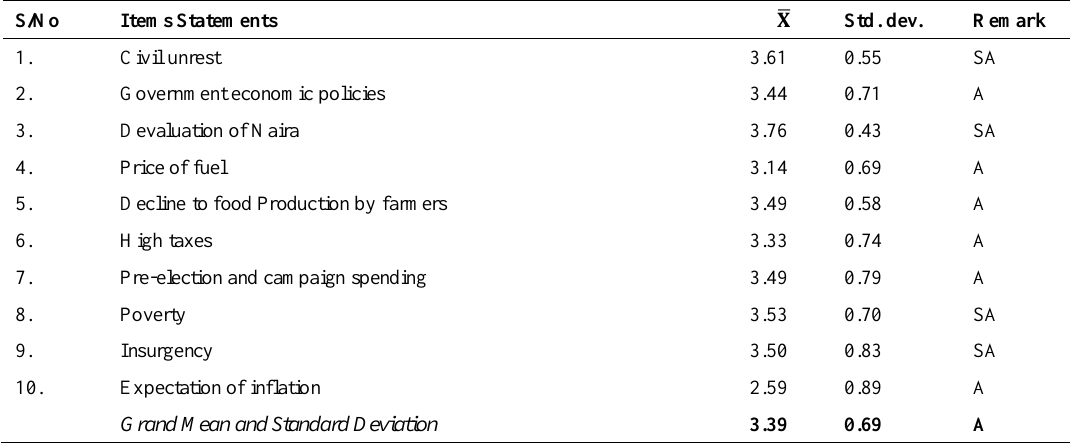
Table 2: Mean and Standard deviation of responses of respondents on the major factors responsible for inflation in Nigeria